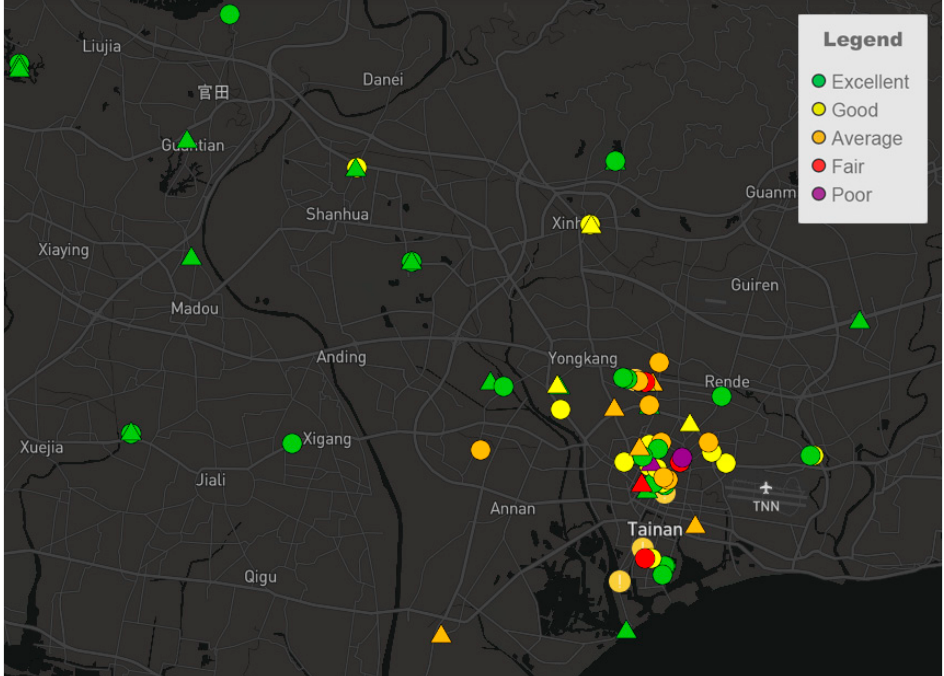
Figure 5. Check-in marks on the map on the website. The spots show how the users feel regarding the environment.